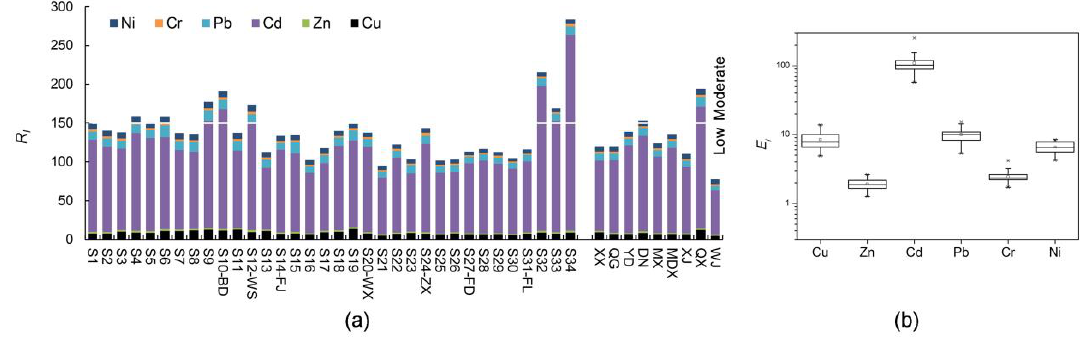
Figure 8. Risk assessment of heavy metals in the sediments. ( a ) the comprehensive index R I of potential ecological risk (the white line represents the split line between the low and moderate ecological risk levels); and ( b ) the statistics of E i r for each heavy metal.